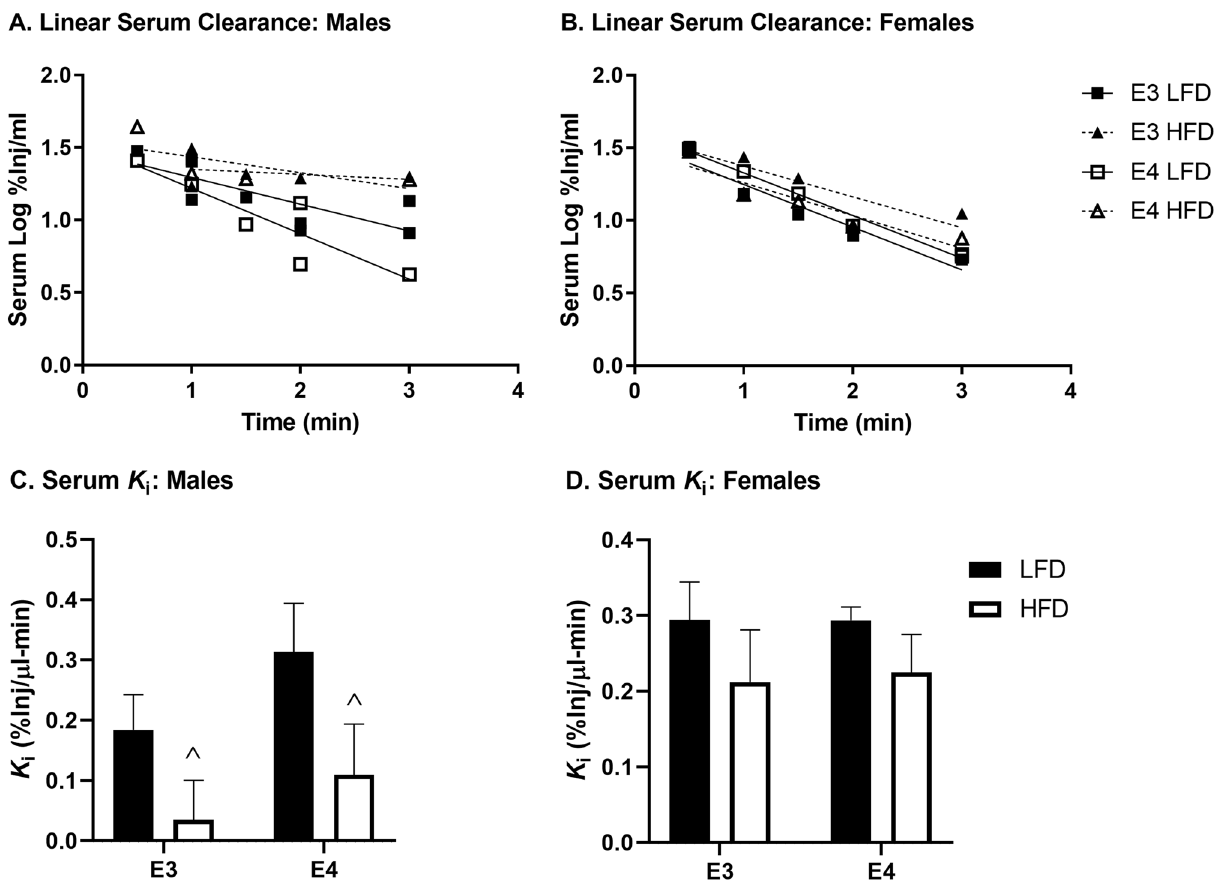
Figure 4. Linear 125 I-insulin serum clearance. 125 I-insulin serum clearance curves for ( A ) males were decreased due to HFD compared to LFD but did not differ in ( B ) females. Clearance rates ( K i ) were calculated for ( C ) males and were significantly different due to diet (^ p < 0.05) but not for ( D ) females. There were not post-hoc